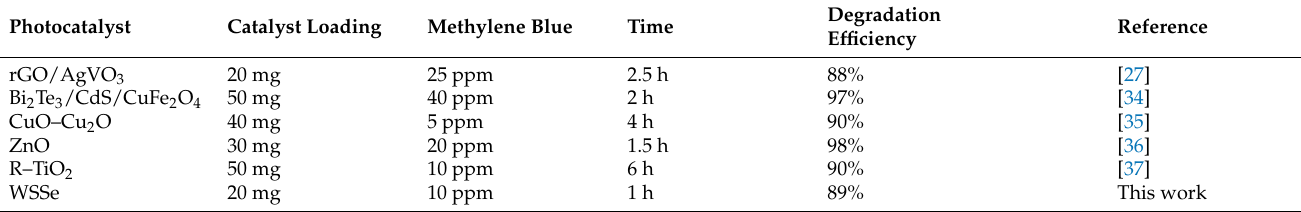
Table 3. Studies of nanocomposite photocatalysts for the degradation of the MB pollutant.